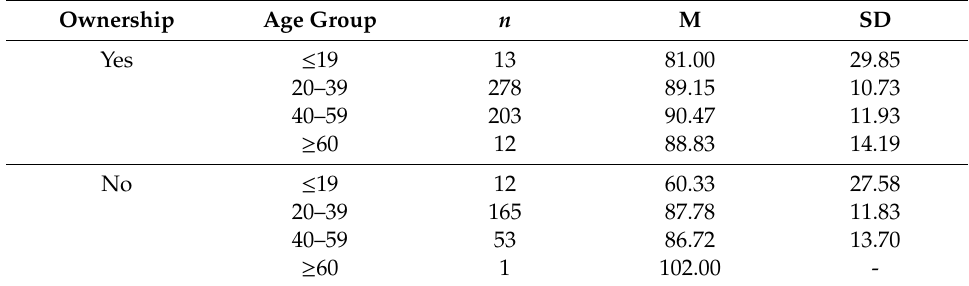
Table 4. Descriptive statistics on the BNS-R among age group by ownership.